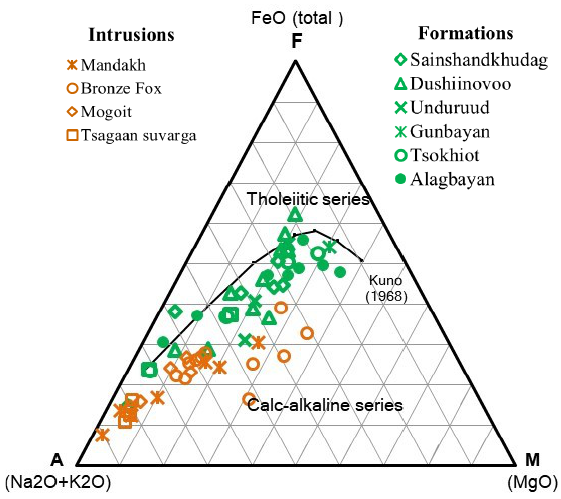
Figure 3 . AFM diagram for magmatic rocks in the Mandakh area. The boundary between the calc-alkaline field and the tholeiitic field after Kuno,